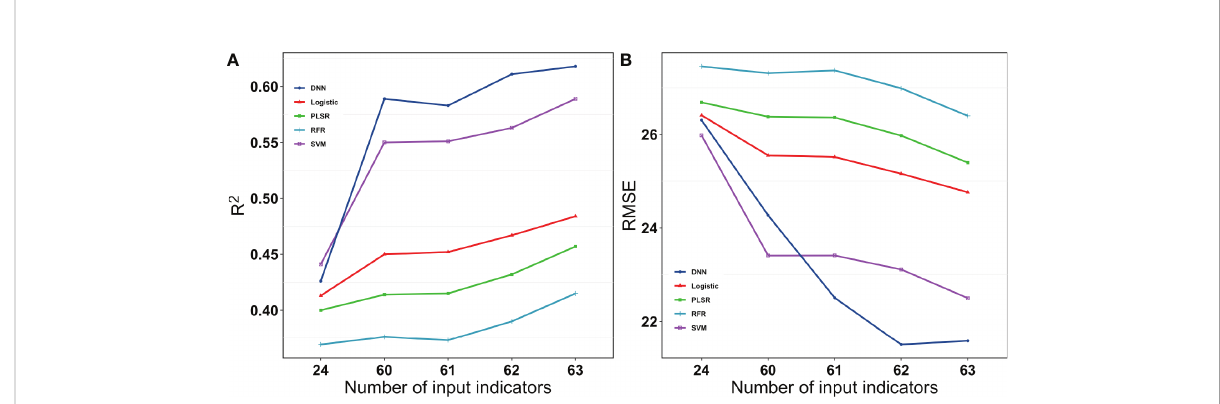
FIGURE 11 R 2 and RMSE for different models with different numbers of input Indices for the grain number of seeds per plant. 24 were vegetation indices. 60 were vegetation indices and texture indices. 61 were vegetation indices, texture indices, and canopy cover. 62 were vegetation indices, texture indices, canopy cover, and crop height. 63 were vegetation indices, texture indices, canopy cove, crop height, and lodging.